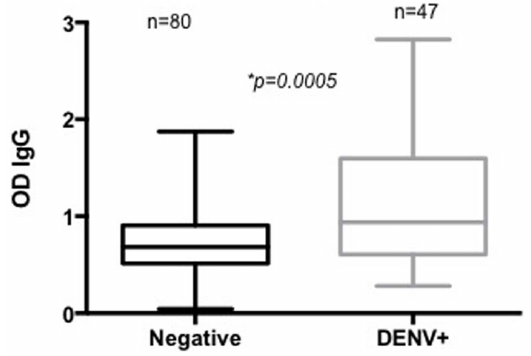
Figure 2. A: Concentration of anti- Ae.aegypti SGE antibodies according to the acute dengue infection status in Los Patios in subjects with DENV ( + ) (DENV + ) and subjects without infection (DENV-). Statistical significance of Mann-Whitney test (*) p , 0.05.